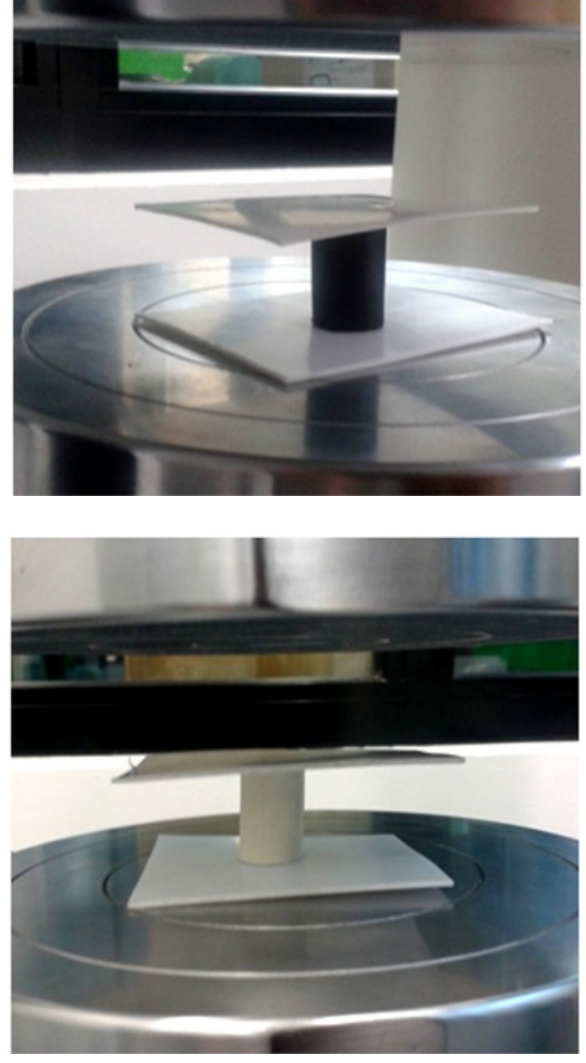
Figure 3: Way of samples mounting between resistance device flat